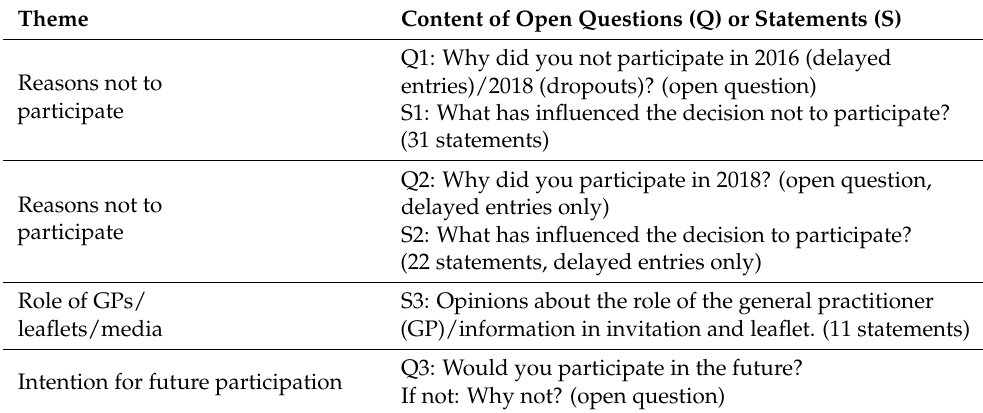
Table 4. Summary of the open survey questions and fixed